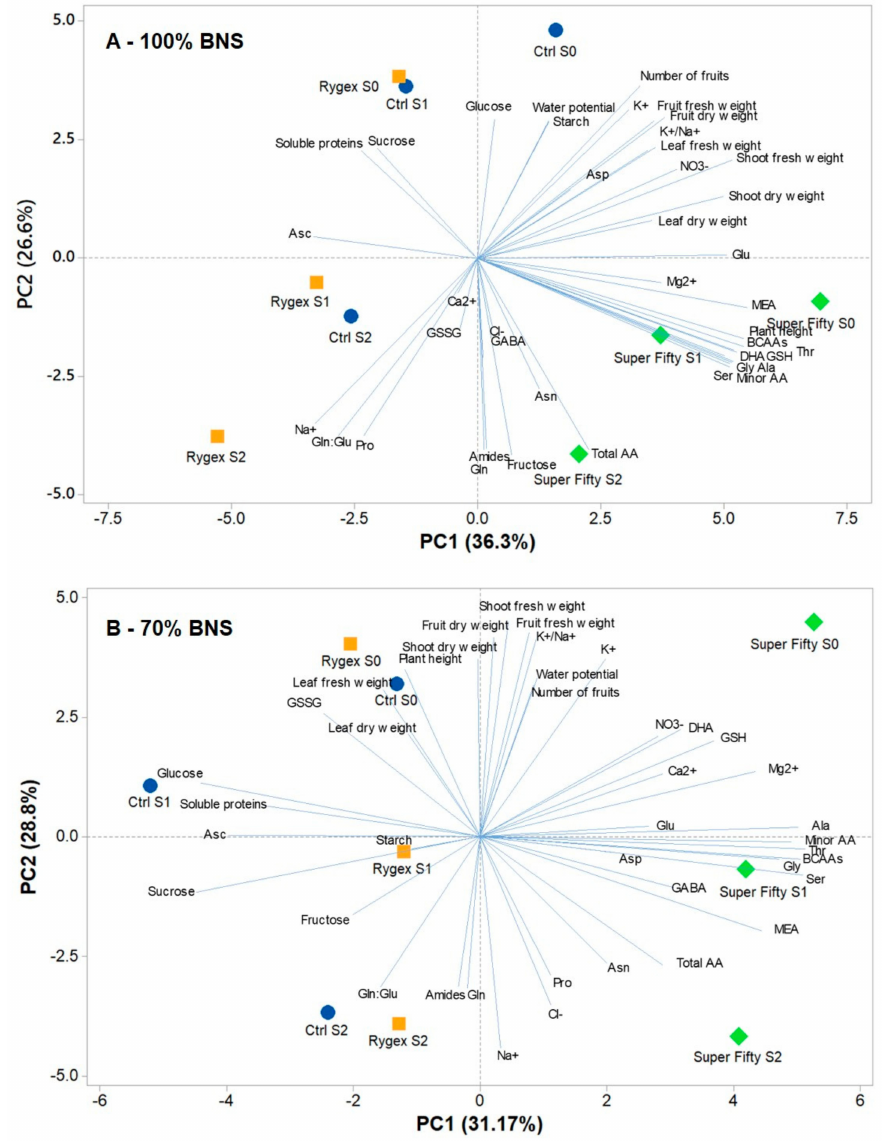
Figure 3. Principal component analysis (PCA) of morphological, physiological and biochemical parameters of MicroTom tomato plants harvested at 90 DAS after being fertigated since 35 DAS with a 100% ( A ) or 70% ( B ) basic nutrient solution (BNS), in combination with three salinity levels of 0, 42.5, and 85 mM NaCl (S0, S1, and S2, respectively) and two different commercial Ascophyllum nodosum extracts (Rygex at 2.5 mL L − 1 and Superfifty at 2.0 mL L − 1